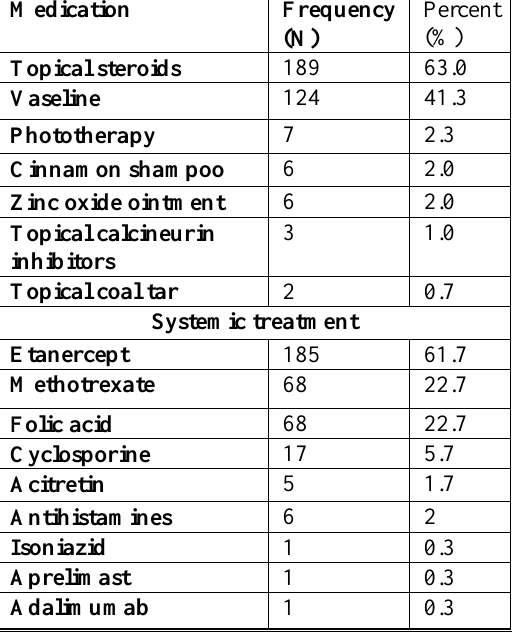
Although the averages PASI and BSA were not high, the psoriasis had very large effect on about half of the patient (49.3%) quality of life (average DLQI=11.29) (Table 3 and Figure 2). Table 3 Descriptive characteristics of the disease and patients. Characteristic Minimum Maximum Mean Std. Deviation Disease duration (years)